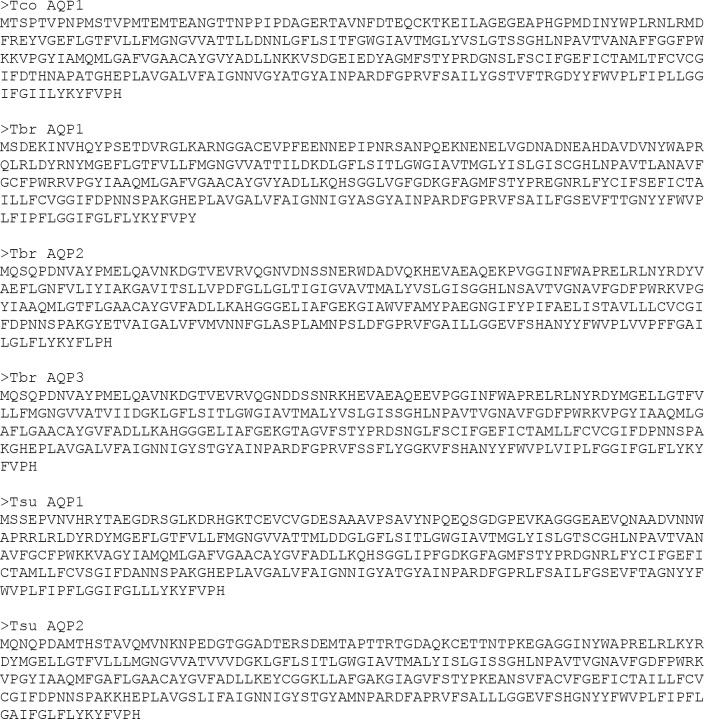
The ratio of non-synonymous v synonymous (dN/dS) codon changes calculated for selected comparisons between T.brucei and T. suis AQPs. The ratios were calculated using a region of high confidence alignments from ~amino acid 60 (highlighted in Figure 1—figure supplement 1) to the C-terminus.